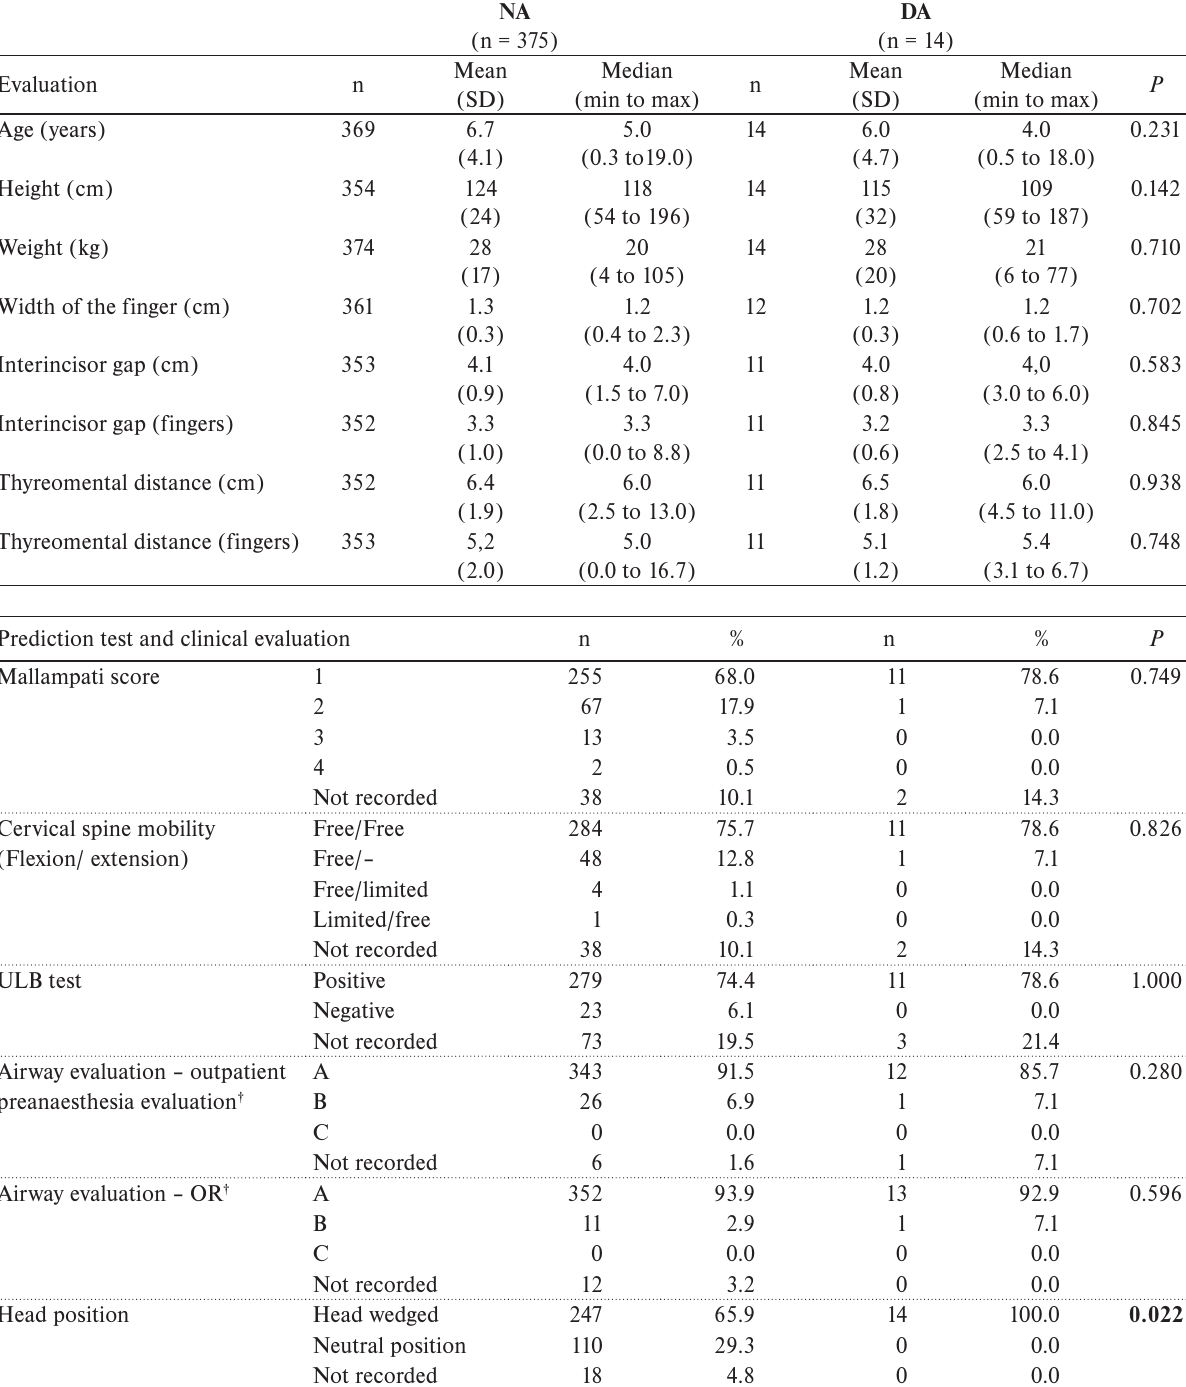
Table 1. Prediction tests and clinical evaluation for Normal airway and Difficult